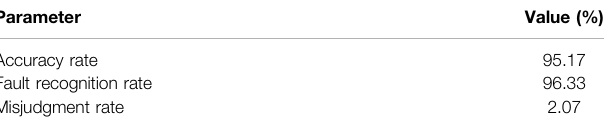
TABLE 3 | Test result in a practical power grid.